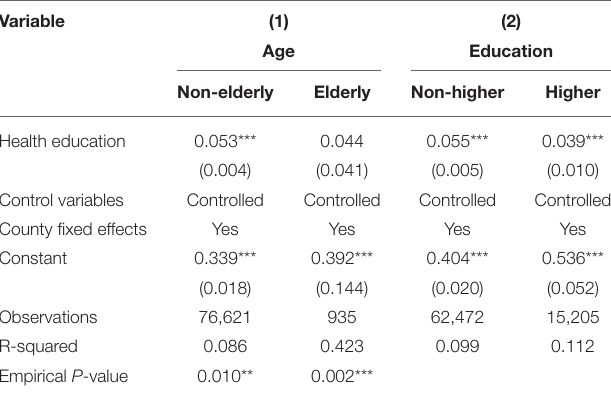
TABLE 9 | The effect of health education on medical service utilization of the migrants on different groups.